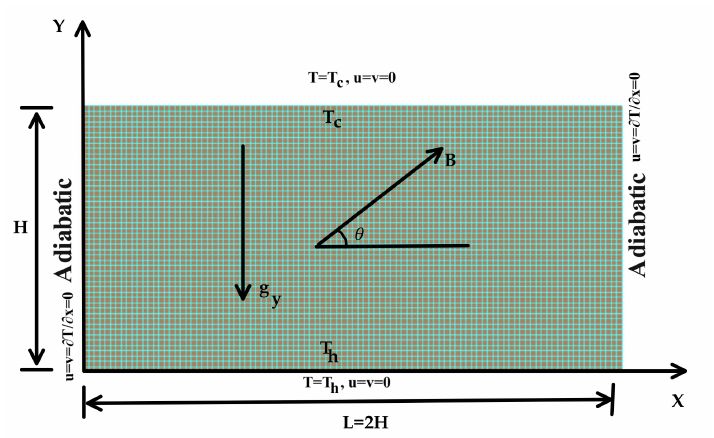
Figure 1. Considered geometry of the rectangular porous cavity along with the magnetic